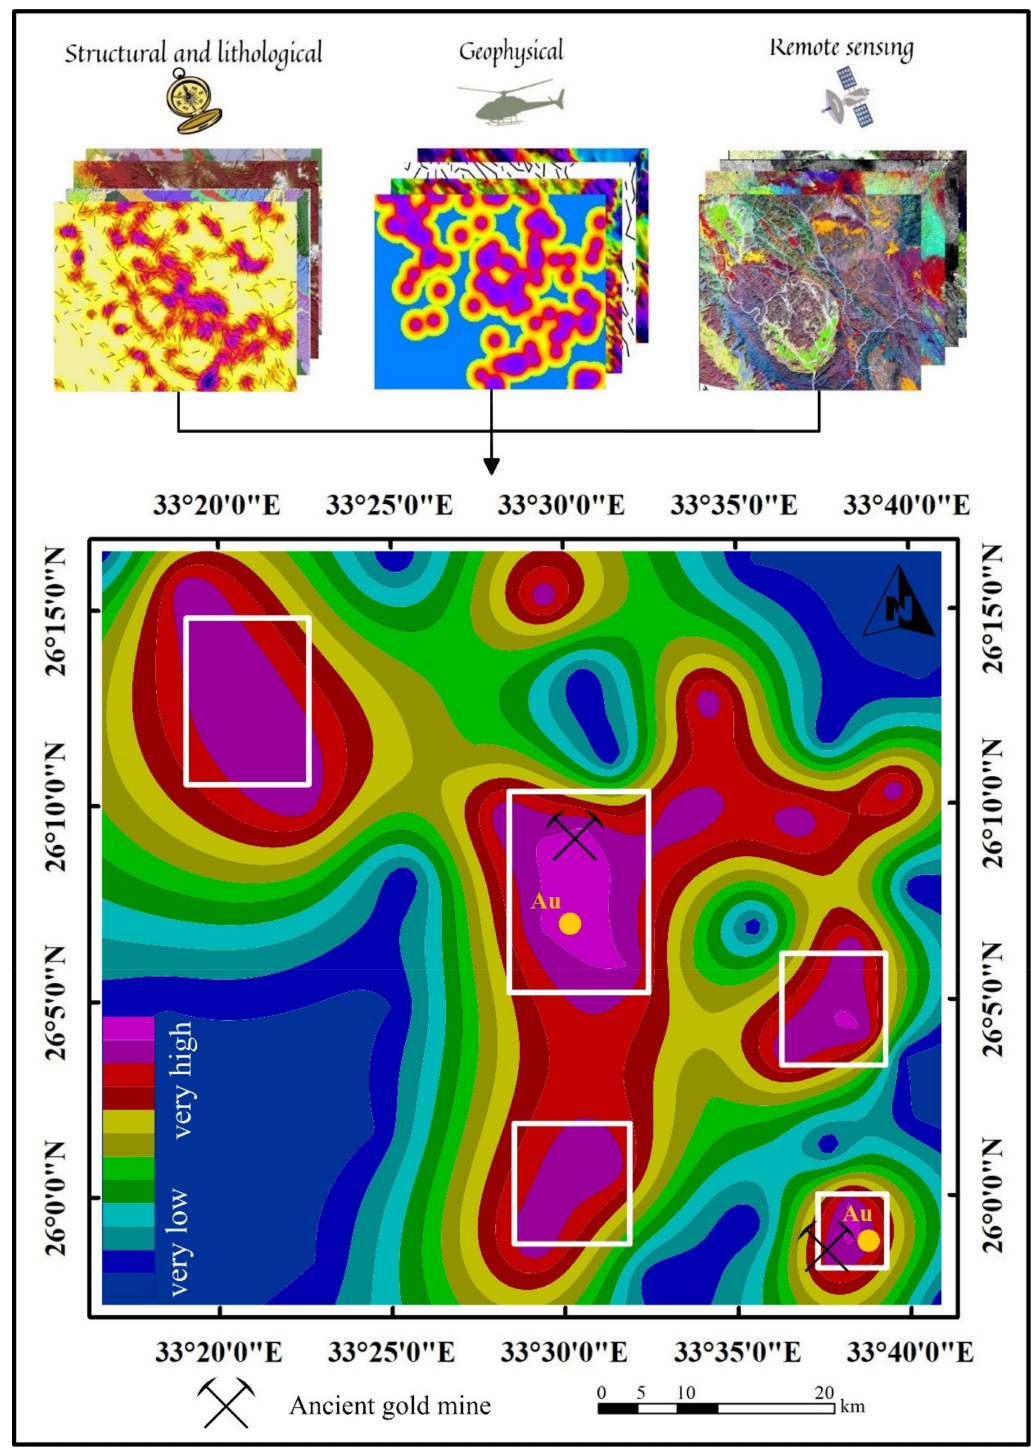
Figure 12. Gold potentiality map (GPM) manifesting an outstanding match with ancient gold mines and highlighting three other promising